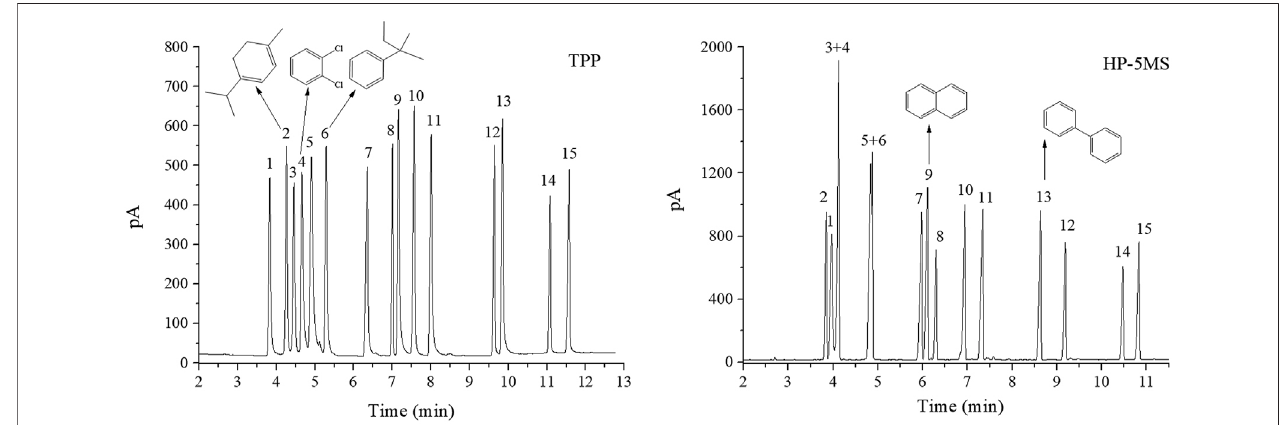
FIGURE 8 | GC separation of a mixture of 15 analytes on TPP column and HP-5MS column. Peak: (1) methyl heptanoate, (2) α -terpinene, (3) ocimene, (4) o-dichlorobenzene, (5) fenchone, (6) tert-amylbenzene, (7) nonanol, (8) dodecane, (9) naphthalene, (10) neophyl chloride, (11) perillaldehyde, (12) methyl undecanoate, (13) biphenyl, (14) cis -nerolidol, (15) trans -nerolidol. Temperature program: 60 ° C (1 min) to 160 ° C at 10 ° C min − 1.